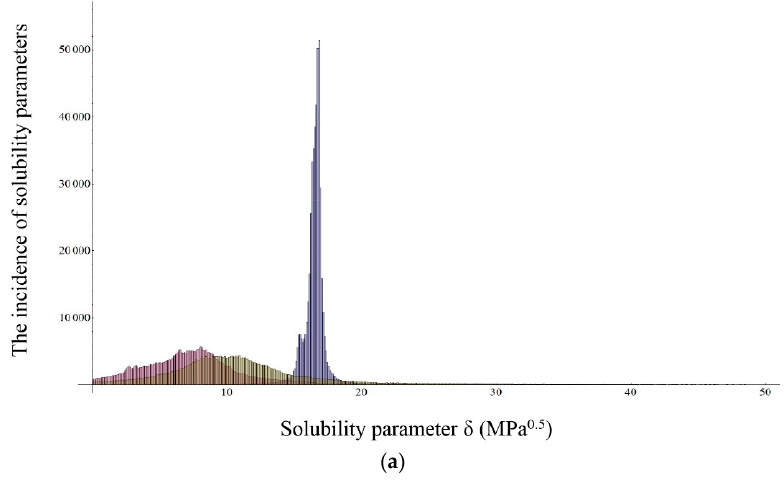
Figure 2. Cont. Figure 2. Cont .